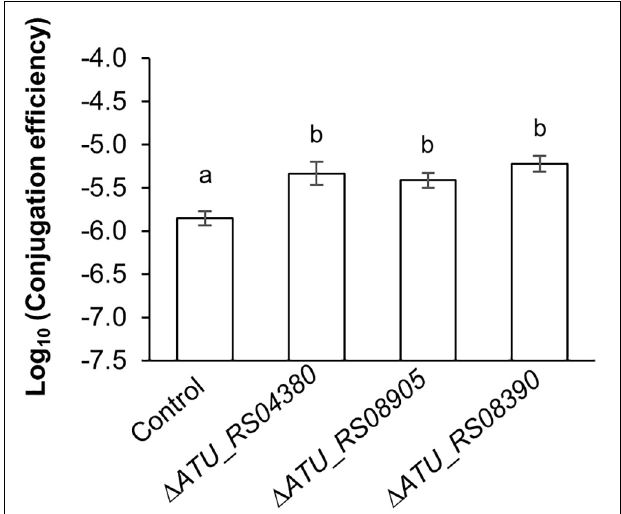
FIGURE 5 | Effect of up-mutant homologs gene-knockout in A. tumefaciens on IncP1-type conjugation. The conjugation reaction was performed for 1 h. Data are presented as mean ± standard error of the mean (SEM) within six experimental replicates ( n = 6). Different letters indicate significant differences between mutants and wild-type control at p < 0.05 using Tukey HSD multiple comparison analysis. BY4742 was used as the recipient. C58C1 parental strain was used as the